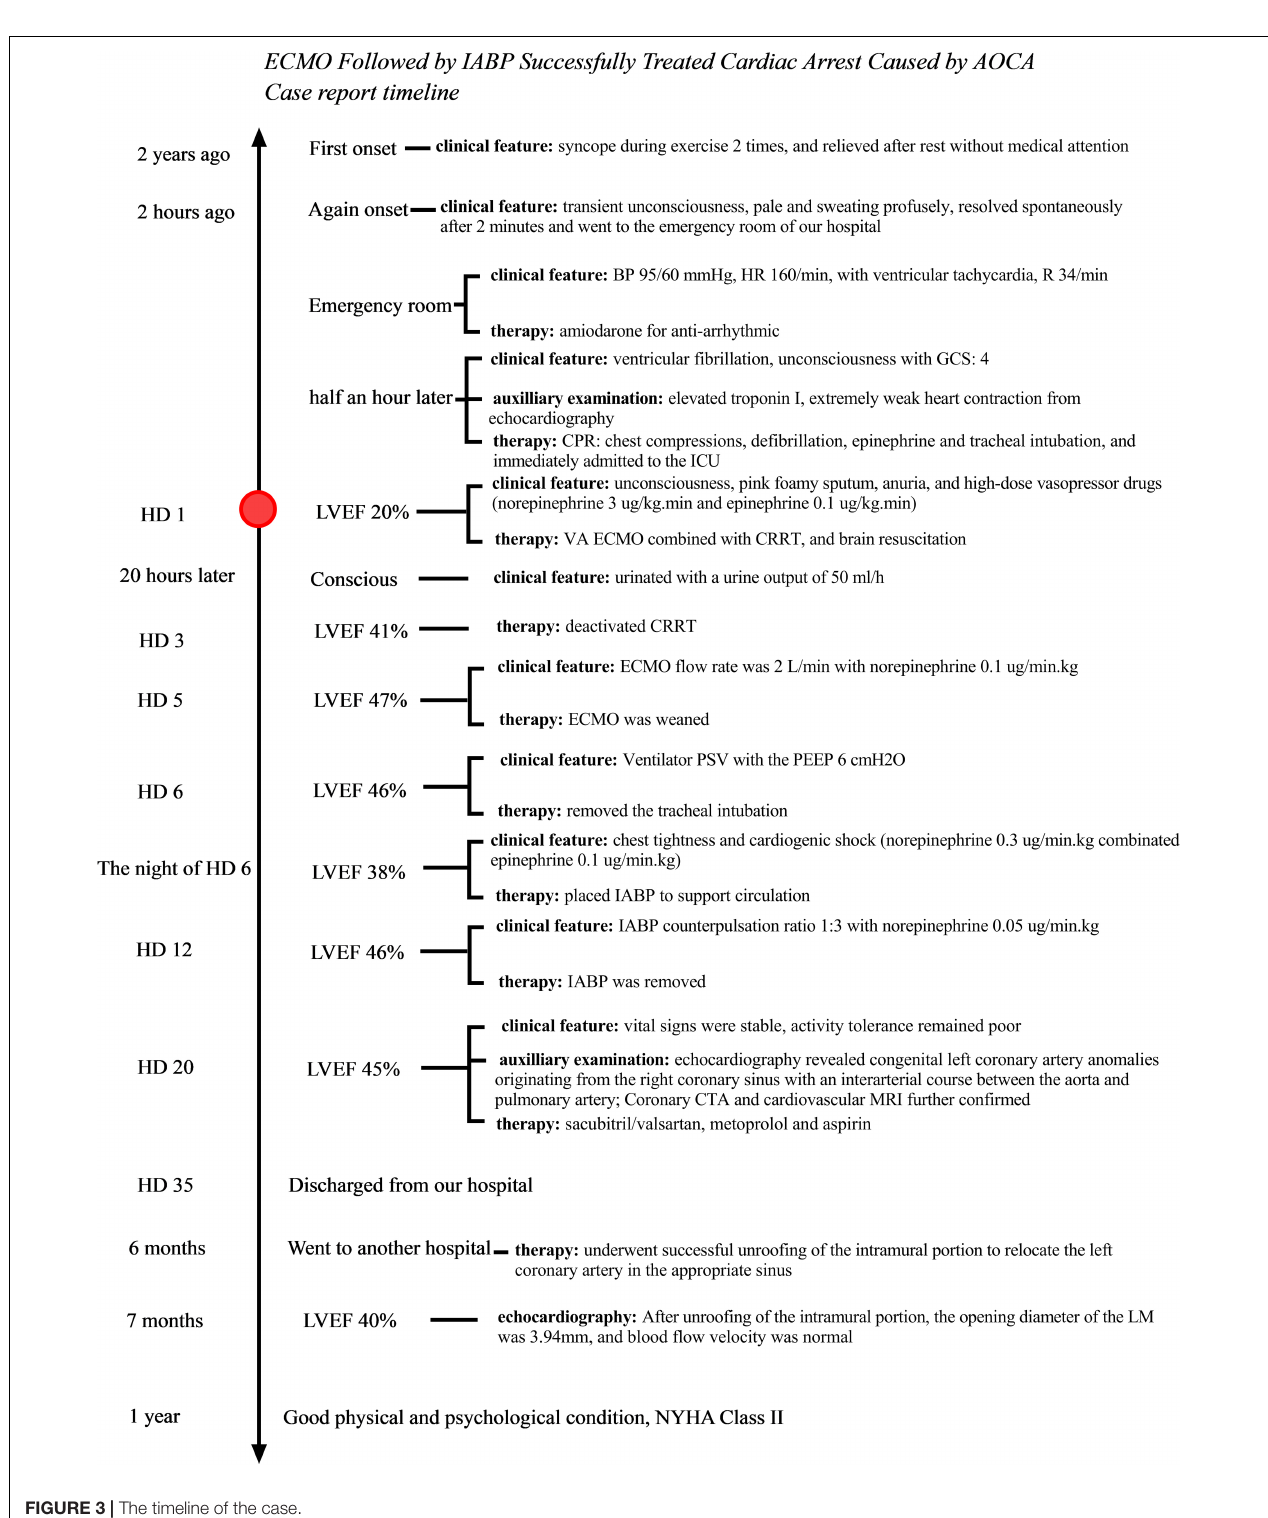
angiography remains critical in the diagnosis and differential diagnosis of patients with cardiogenic shock. Echocardiography in children with cardiogenic shock, attention should be paid to